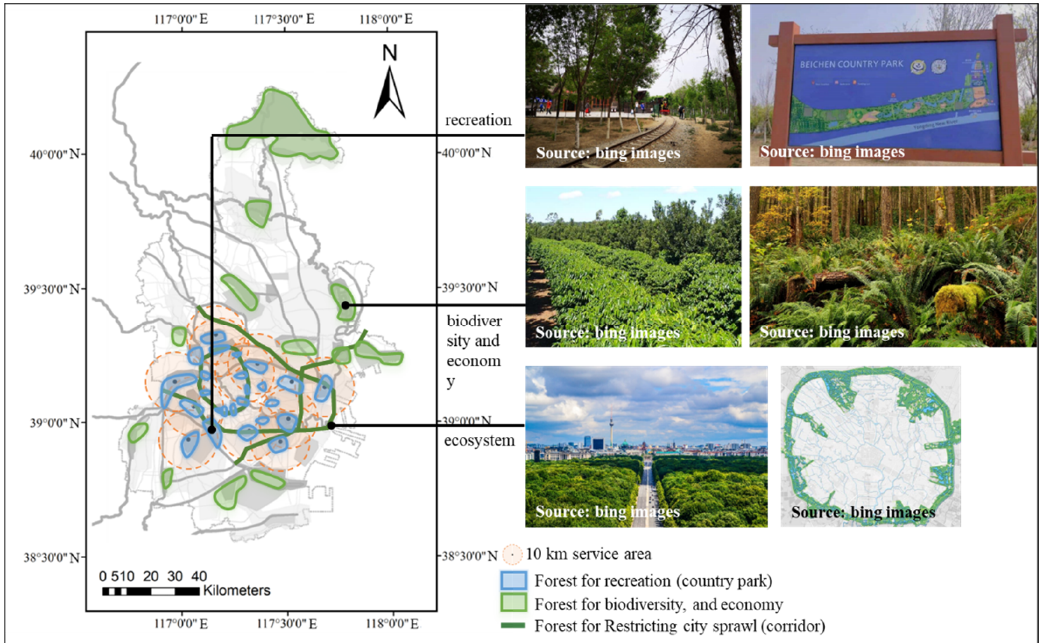
Figure 14. Different benefits of different forests.